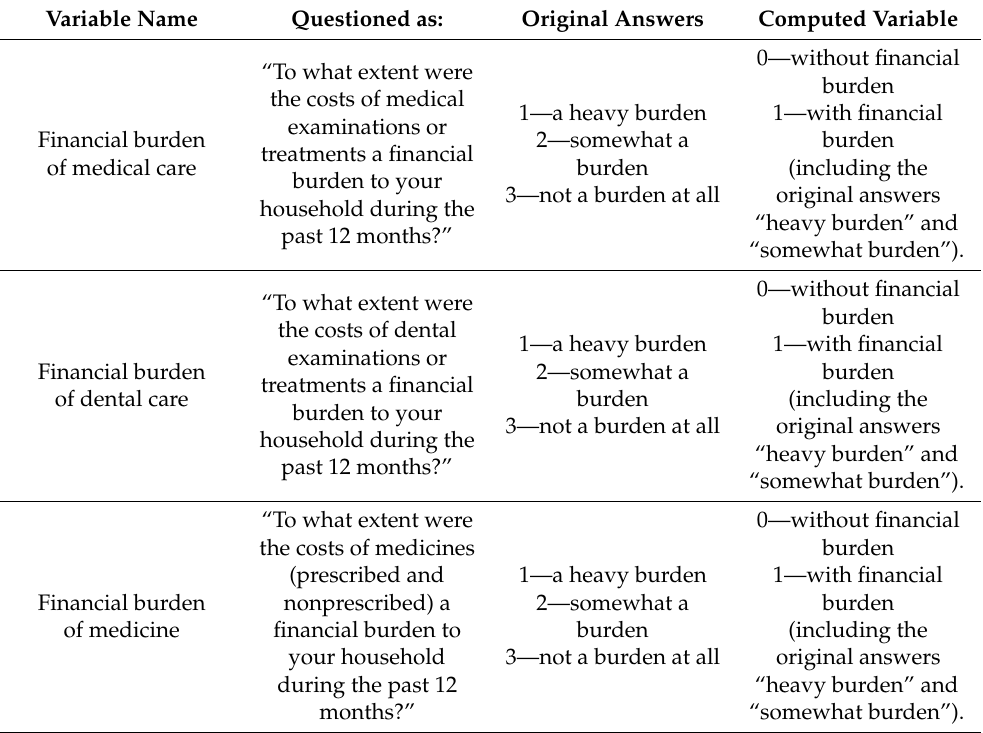
Table 1. The financial burden of healthcare—dependent